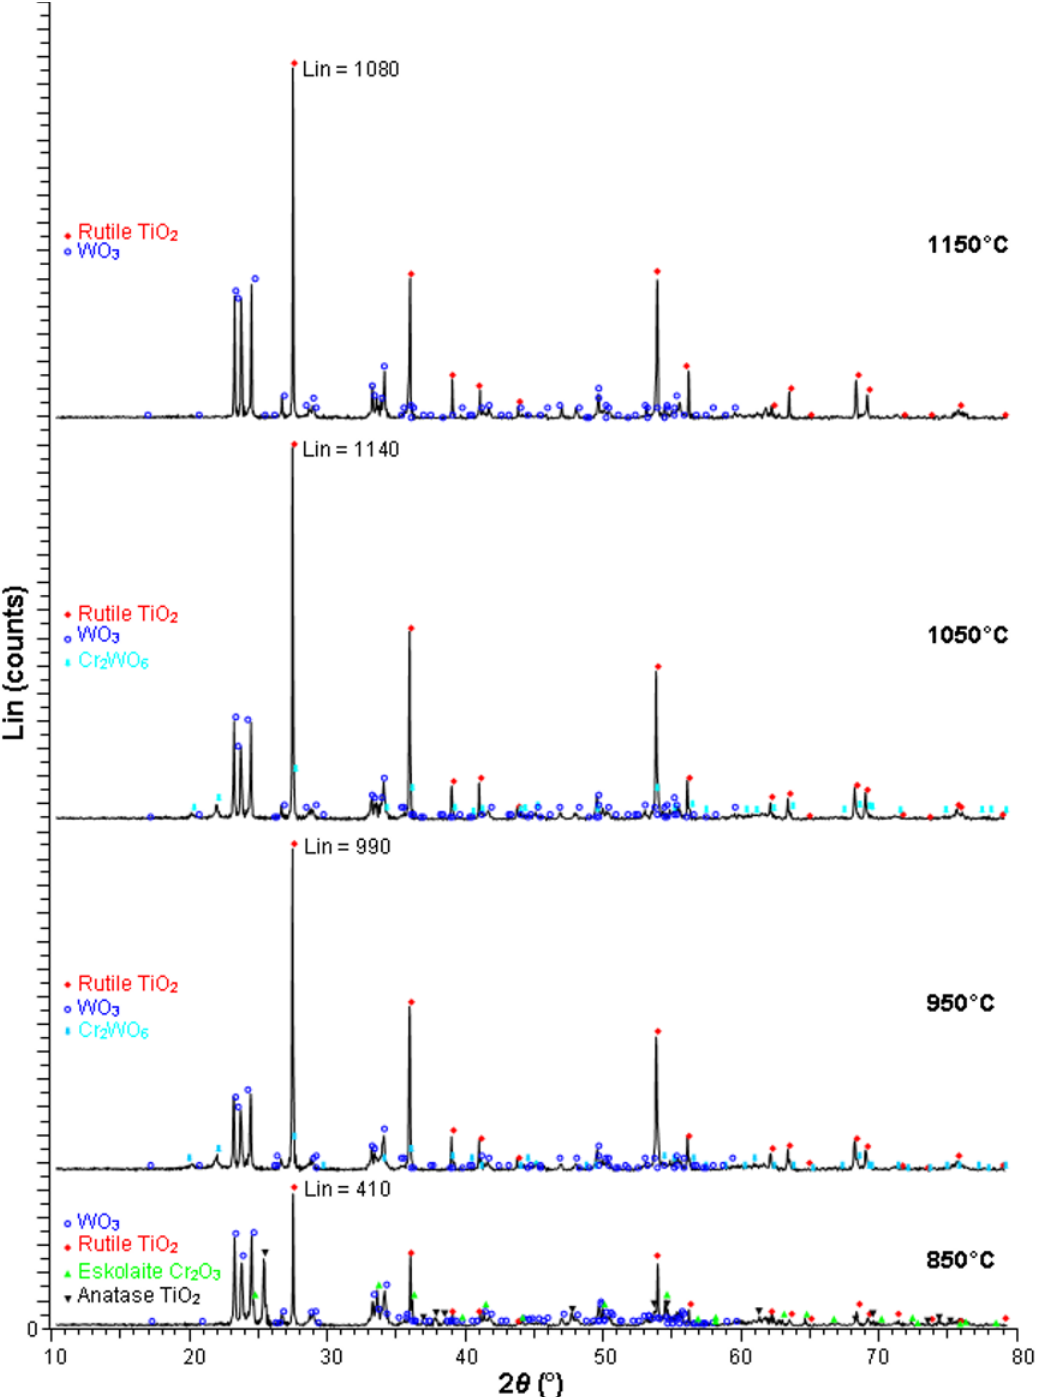
Figure 7. Diffractograms of pigments Ti potential (the least stable dispersion) is linked with a lesser number of phases into pigments. In all cases, the